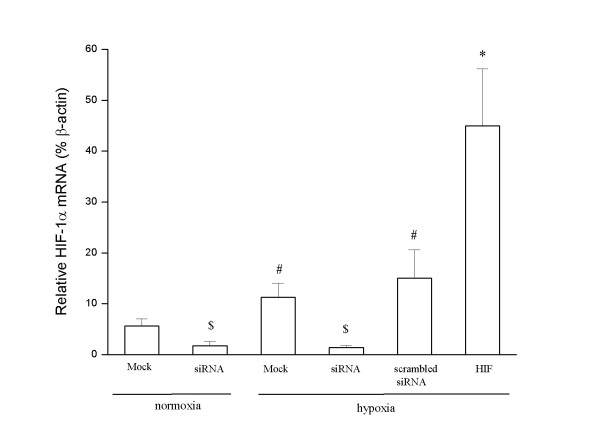
Inhibition HIF-1α mRNA expression in A549 by siRNA. A549 were transfected with the siRNA-expressing EGFP-pSUPER vector or a HIF-1 expression plasmid. Cells were allowed to recover in regular culture medium for 20 h after transfection, then exposed to a normoxic or hypoxic environment for an additional 24 h. Experiments were performed five times with the similar results (n = 5 in each group). $, P < 0.05 compared to control and HIF-1α siRNA; #, P < 0.05 compared to normoxic or hypoxic HIF-1α siRNA; *, P < 0.05 compared to hypoxic mock-transfected and scrambled HIF-1α control siRNA transfection. siRNA: HIF-1α plasmid transfected, Mock: mock transfected, HIF: HIF-1α expression plasmid transfected.